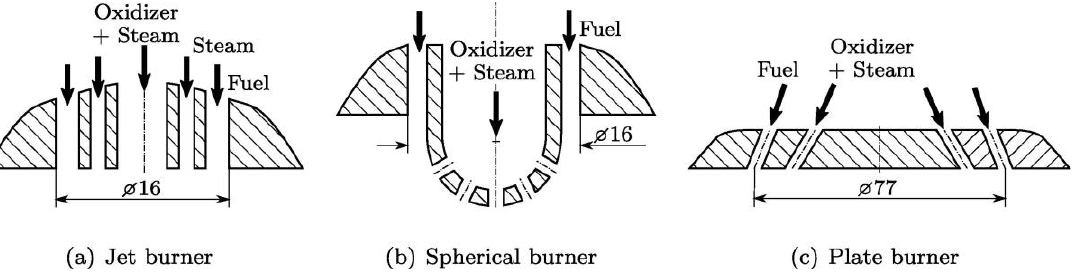
Figure 8. Burner designs used to optimize the HP POX process [82] (copyright with permission from [82], Elsevier, 2017).